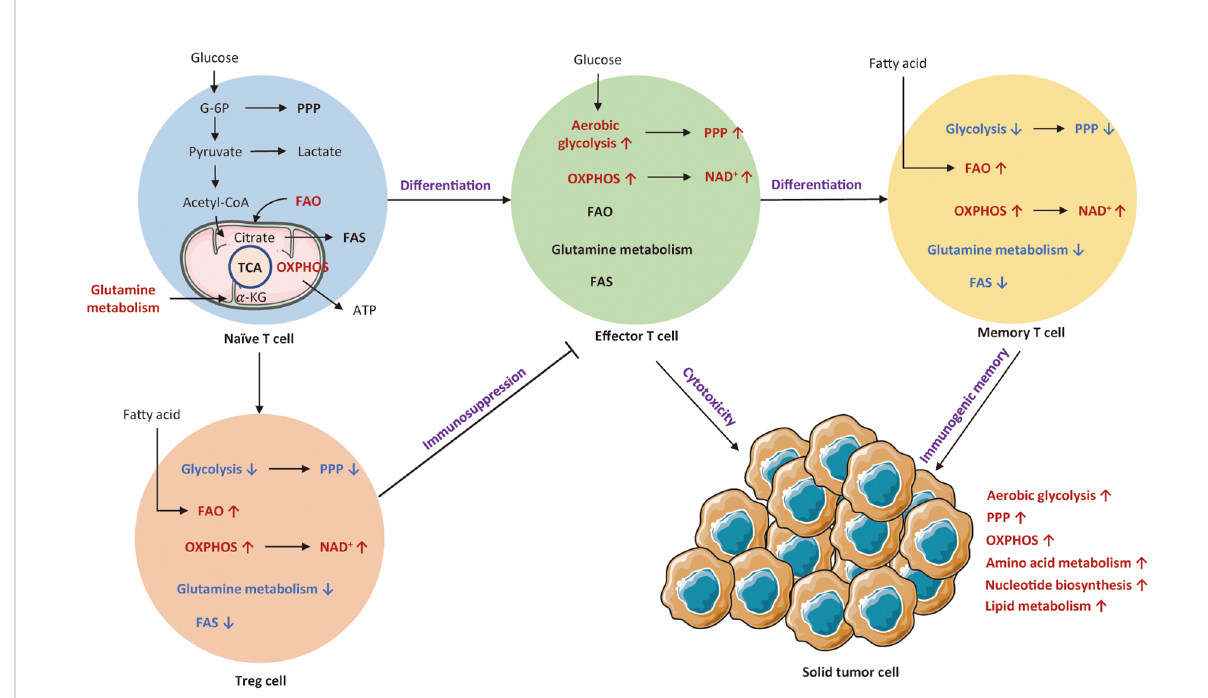
FIGURE 1 An overview of cellular metabolic pathways of different T subsets. Naïve T cell mainly rely on OXPHOS to maintain minimum ATP levels. Upon activation of T cell receptor (TCR) and co-stimulatory signals, naïve T cells shift to effector T cells that are reliant on aerobic glycolysis and OXPHOS. Both Treg cells and memory T cells mainly rely on OXPHOS and FAO for survival. The red arrows and texts represent enhanced metabolism processes, while the blue arrows and texts represent inhibited metabolic pathways. PPP, pentose phosphate pathway; OXPHOS, oxidative phosphorylation; FAO, fatty acid oxidation; FAS, fatty acid synthesis; TCA, tricarboxylic acid; G-6P; glucose-6-phosphate; Treg cell, regulatory T